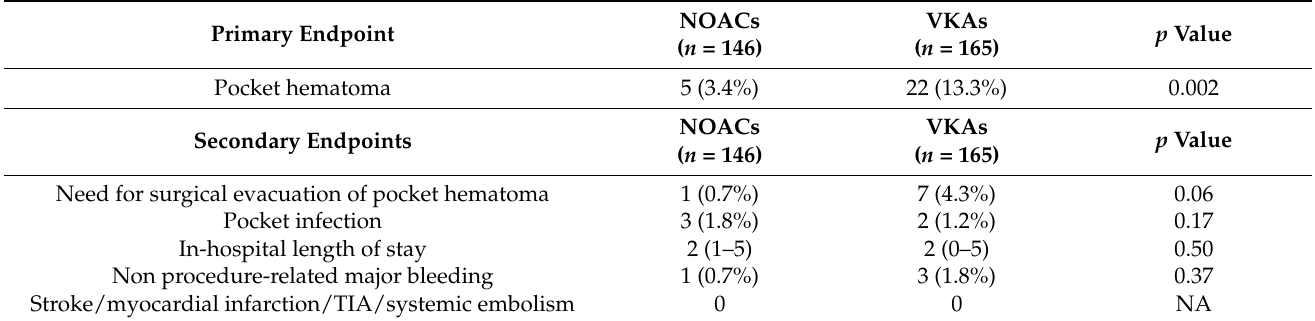
Table 4. Study outcomes at 30-day